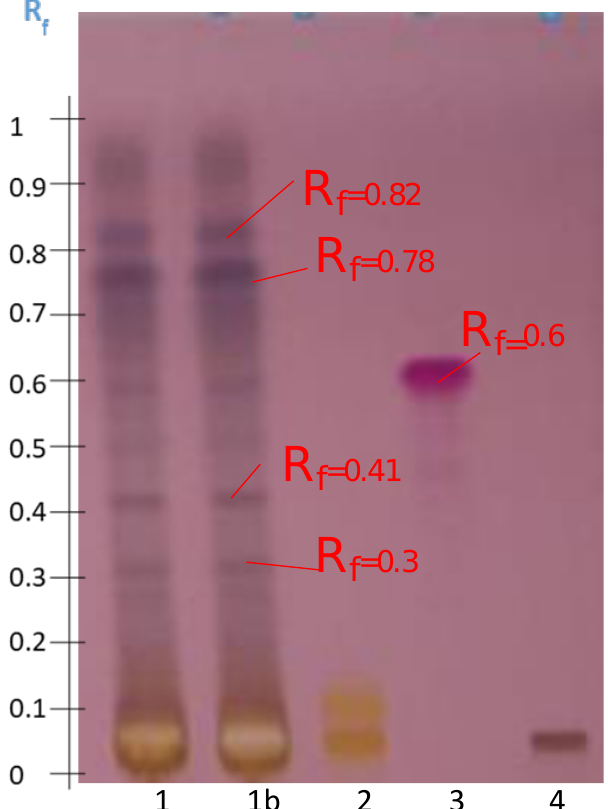
Figure 1. HPTLC profile obtained after migration and visualization with anisaldehyde-H 2 SO 4 of the Bizerte extract according to Protocol M1 (Tracks 1 and 1b) and compared with the standards: solanine (Track 2), senegenin (Track 3), and digitonin (Track 4). Elution system S1.